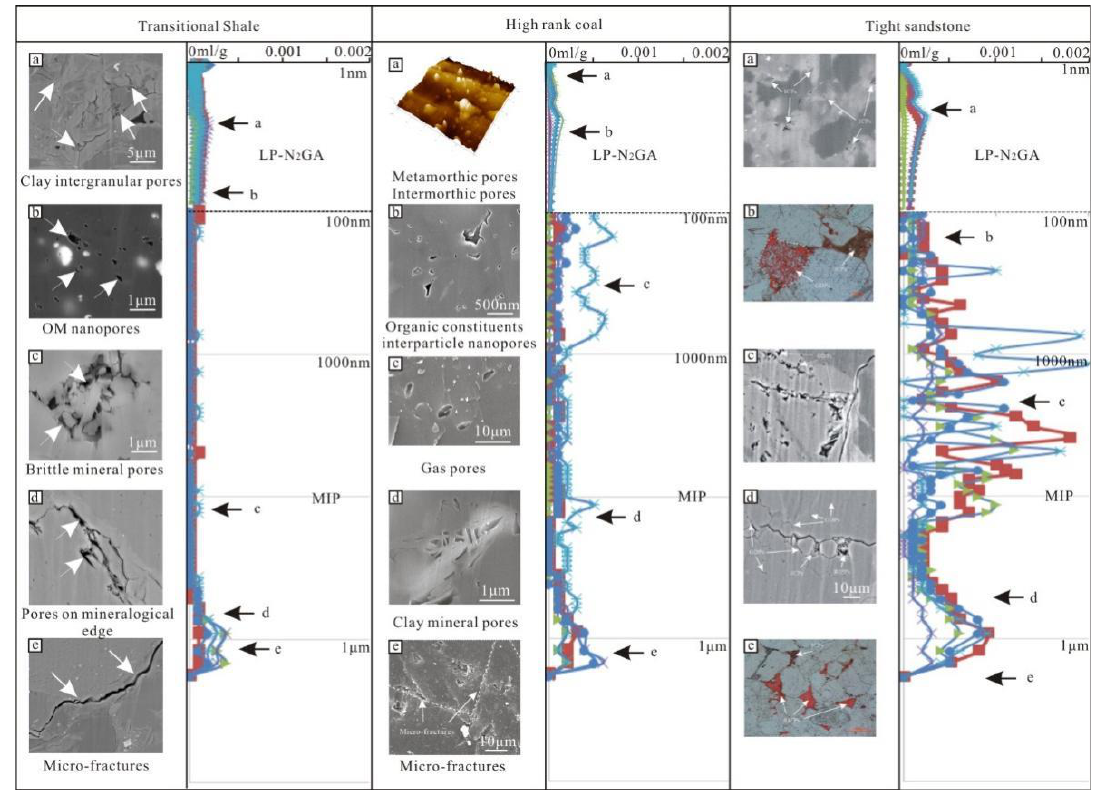
Figure 14. The systematic comparison of reservoir space of high-rank coal, shale, and tight reservoirs at the nanoscale to fracture scale. ( a – e ) Representative pore types of pores with different size